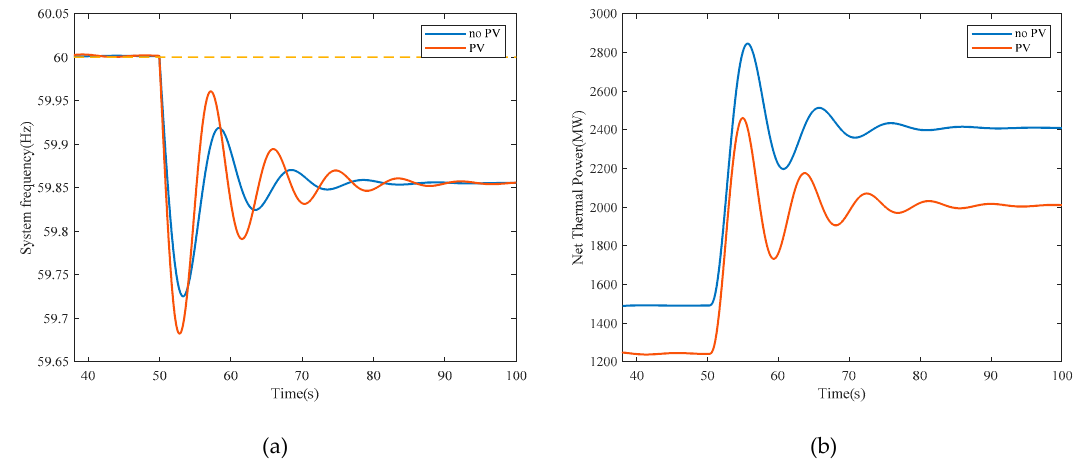
Figure 6. Baseline analysis of the test system in pump mode of CPSH.